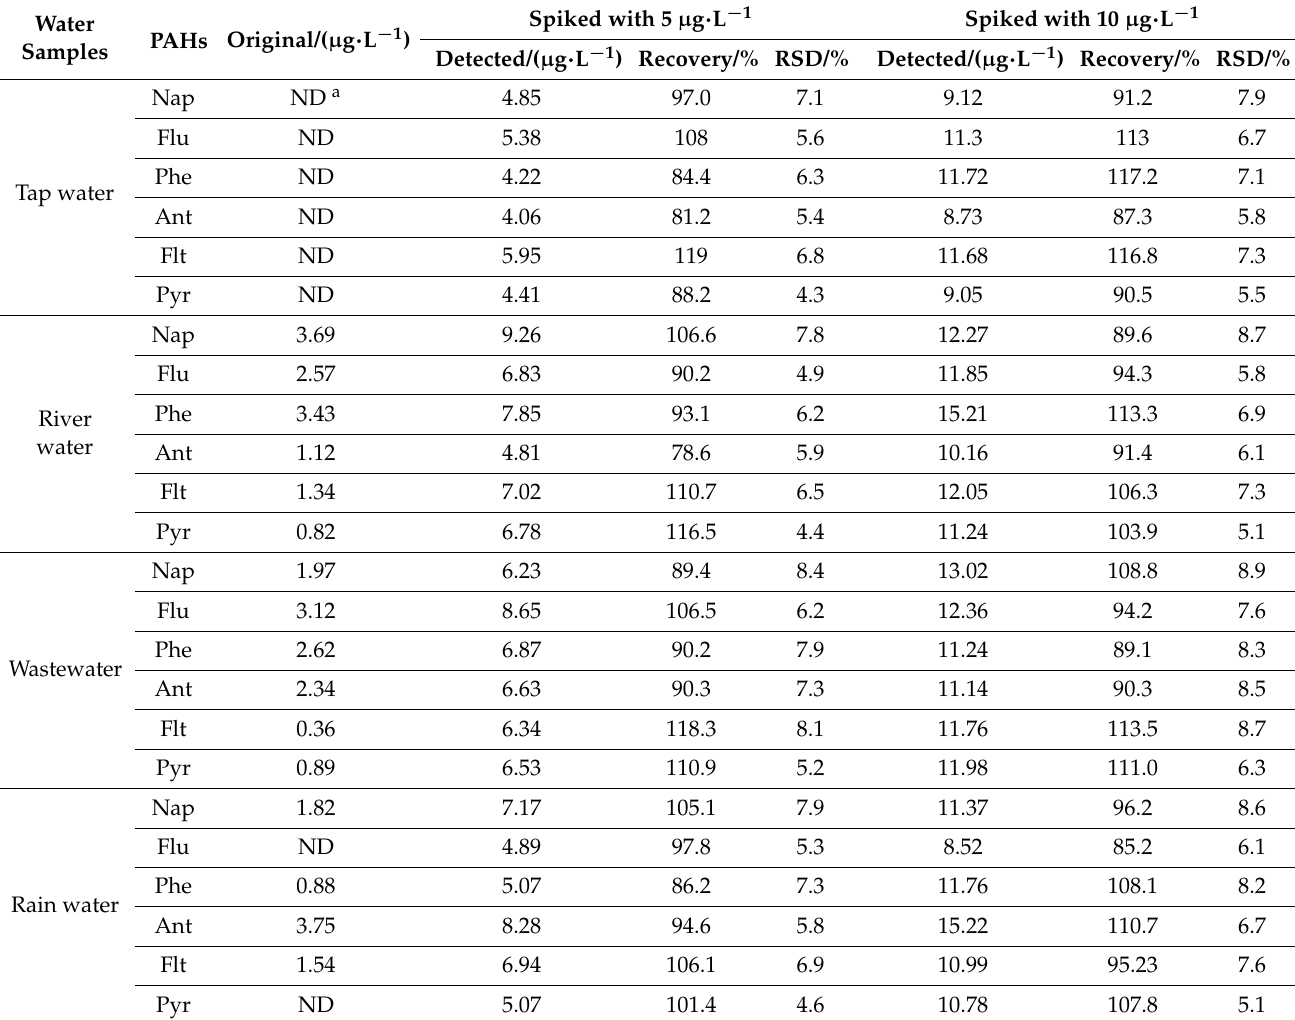
Table 2. Analytical results of PAHs in different environmental water